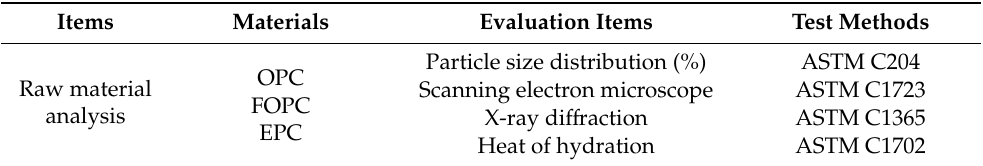
Table 4. Test plan for raw material properties.